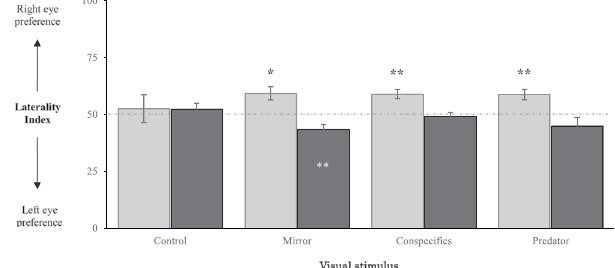
Figure 4. Effect of pesticides on the visual preference of A. triostegus larvae. Figure represents LI mean ( ± SE) values. Asterisks indicate significant differences (Mann-Whitney U tests, * p < 0.05; ** p < 0.01) between Laterality Index (LI) values and the theoretical 50% value (dotted line). Black asterisks above bars indicate a significant right-eye preference, while white asterisks below bars indicate a significant left-eye preference. 10 to 11 replicates (one fish per replicate) were conducted for each visual stimulus in both the pesticide exposition experiment (black bars) and the solvent-control exposition experiment (grey